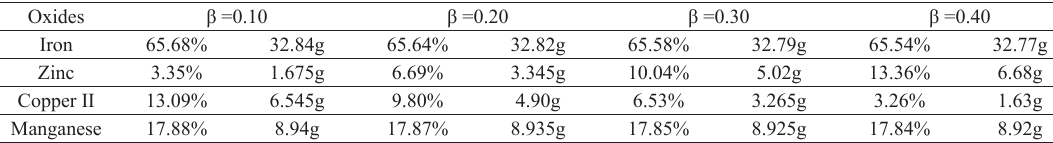
Table 2. Summary of stoichiometric oxide powders calculations for a mass of 50g. Oxides β